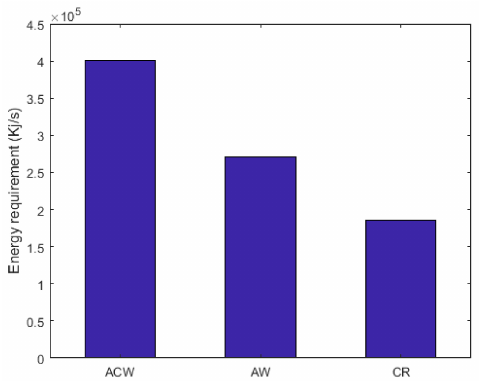
Figure 11. Energy requirement comparison between CR, AW, and ACW configurations.